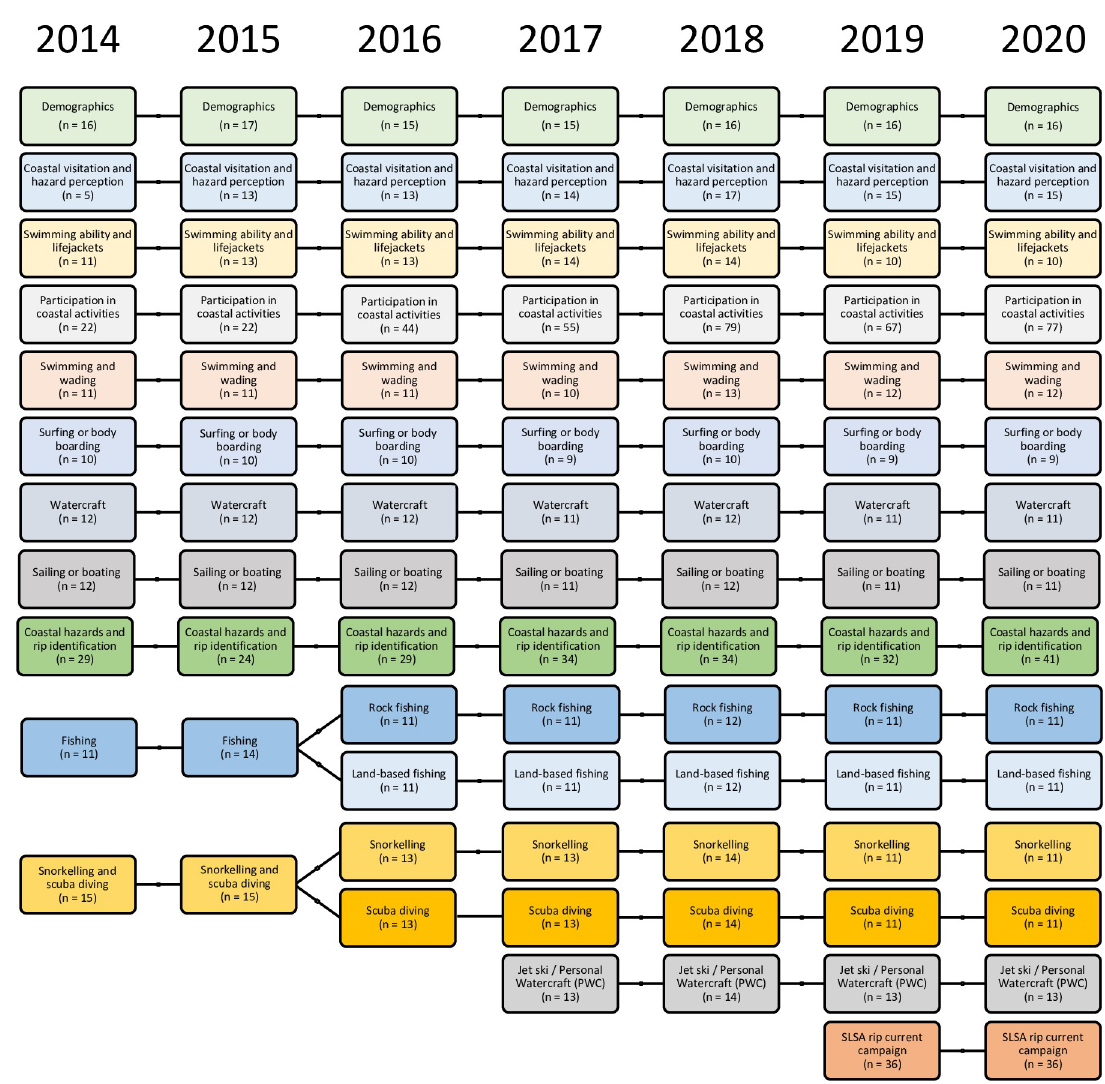
Fig 1. Structure of surf life saving Australia’s national coastal safety survey over time illustrating the number of topics and numbers of questions asked each year. Colours delineate general different topics for each year and illustrate how they have been